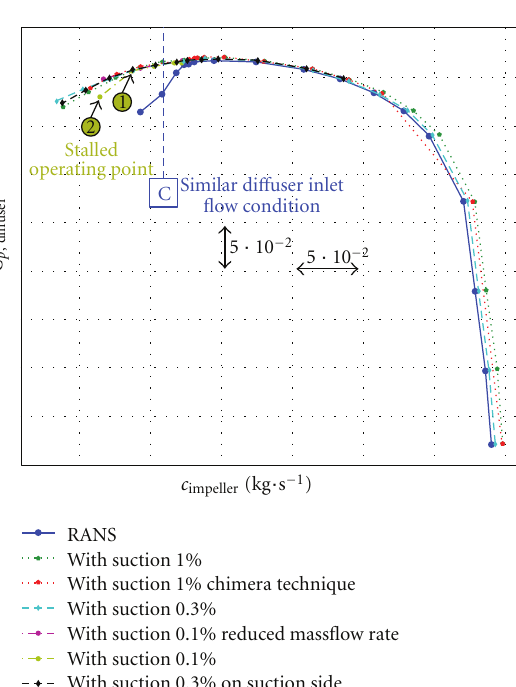
Figure 17: Static pressure recovery coe ffi cient of aspirated di ff user.